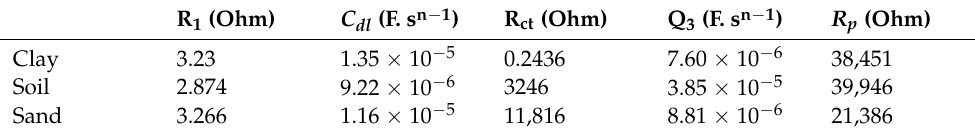
Table 4. Impedance parameters and corrosion resistance of the coated steel.